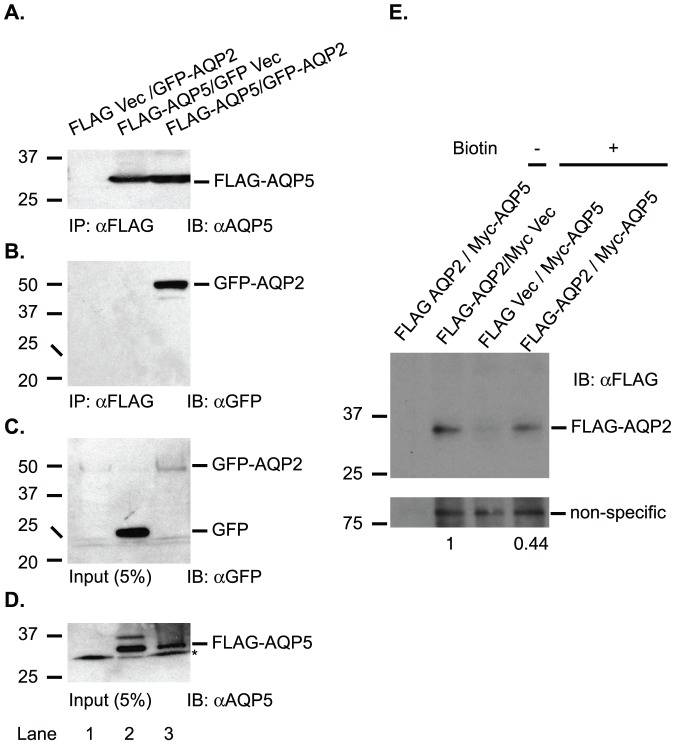
AQP5 coimmunoprecipitates with AQP2 and impairs its cell surface localization in IMCD3 cells.(A–D) Co-IP showing human AQP5 interacts specifically with human AQP2. AQP5 and AQP2 were expressed as FLAG- or GFP- fusions in 293T cells, and analyzed by IP-IB with antibodies as indicated. (E) Representative IBs of biotinylation assay showing that AQP5 impairs cell surface localization of AQP2. FLAG-AQP2 and Myc-AQP5 were expressed separately or in combination in IMCD3 cells, biotinylated, and analyzed by IB with antibodies as indicated. *: unknown protein.